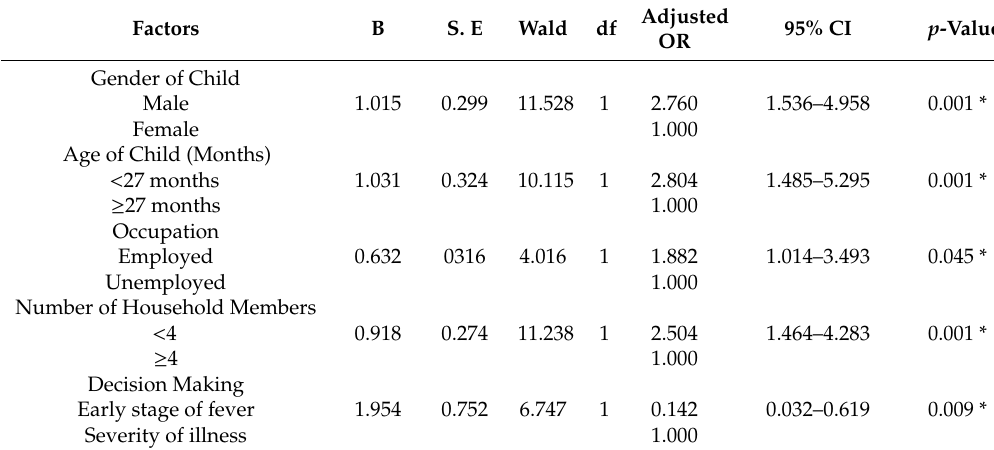
Table 5. Multiple logistic regression showing adjusted odd ratio (AOR) of predictors of appropriate health seeking